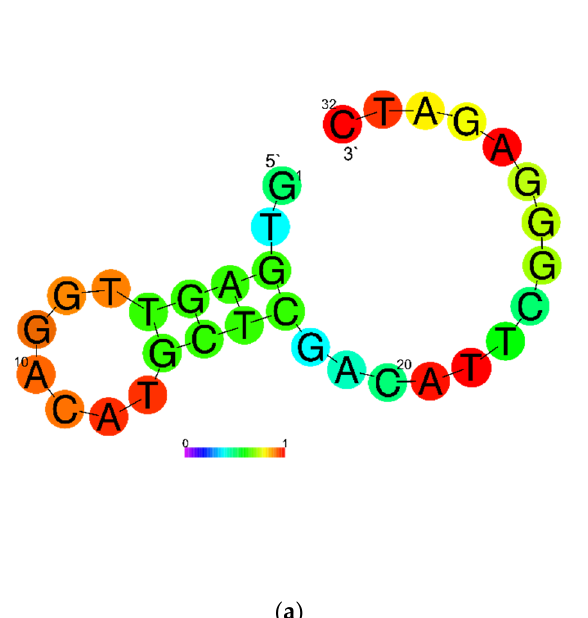
Figure 2. The possible secondary structure of ssDNA1 ( a ) and guide RNA ( b ) obtained by RNAFold webserver [38]. The gradient scale at the bottom shows the probability of base pair formation: blue color—the lowest probability (0); red color—the highest (1).